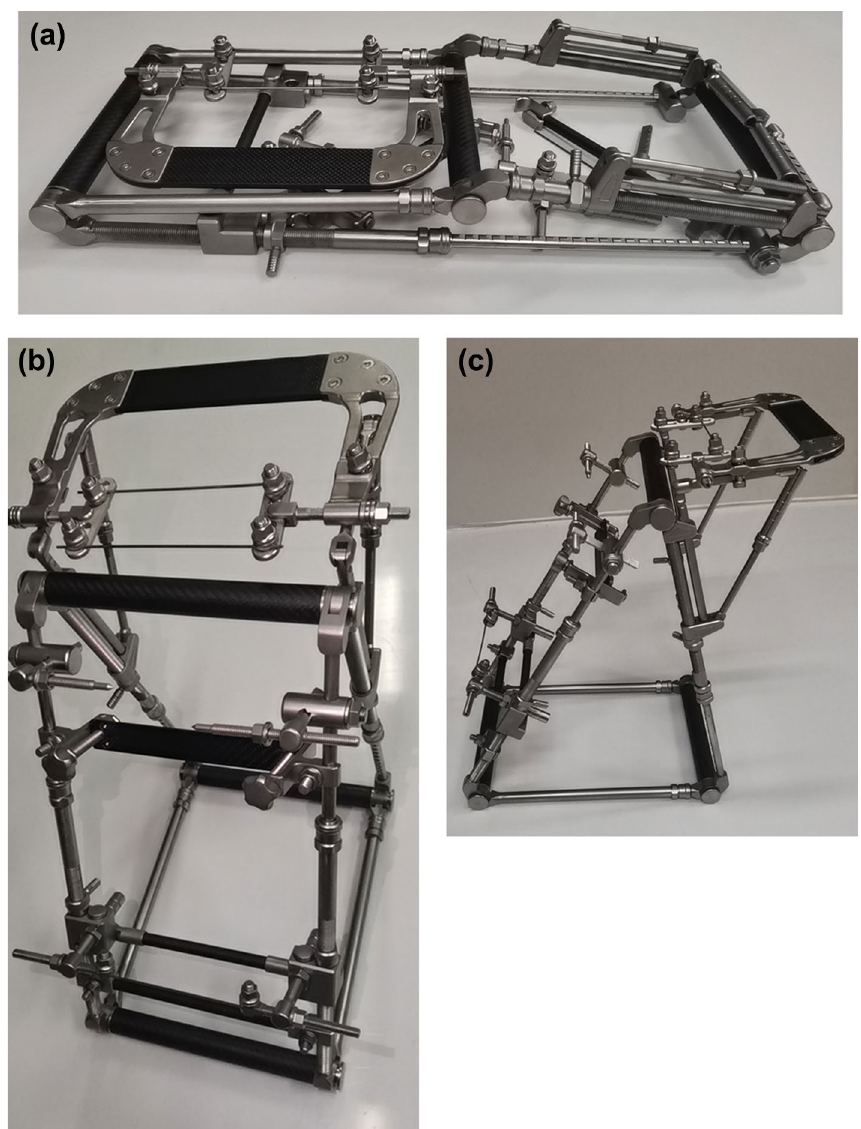
Figure 1. The photos of a multiplanar fracture redactor. ( a ) The view of before installation, ( b ) the antero- posterior view, ( c ) the lateral view.